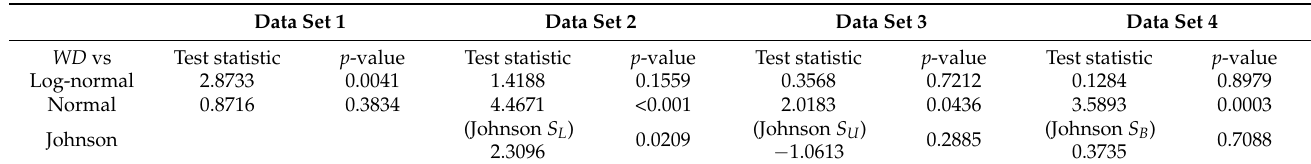
Table 2. Vuong test of WD vs. some models for all data sets.